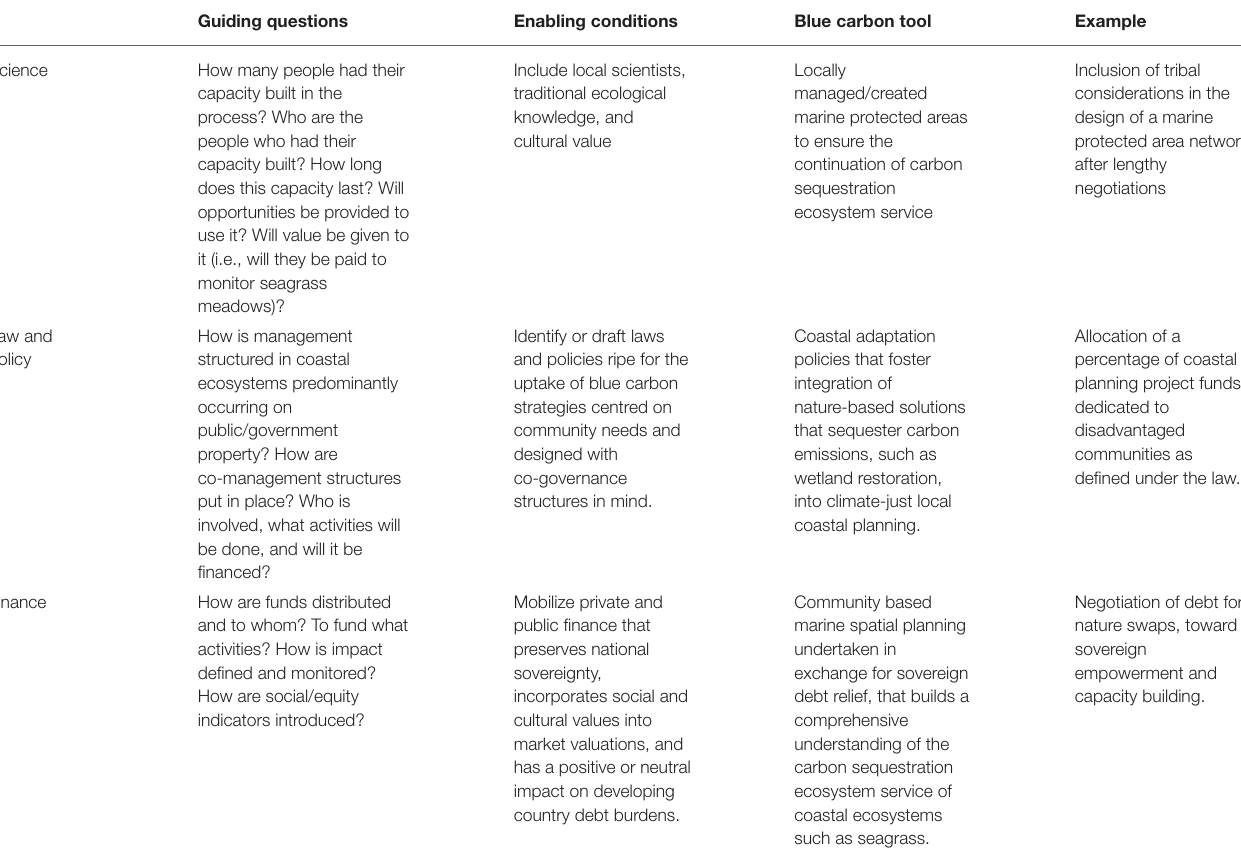
TABLE 1 | National and subnational examples leading the way in operationalizing climate-just blue carbon